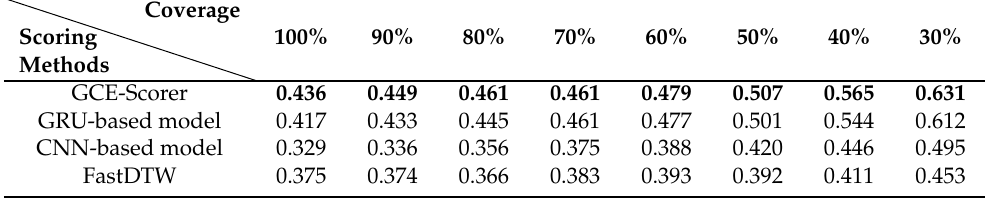
Table 4. Accuracy through different scoring methods.